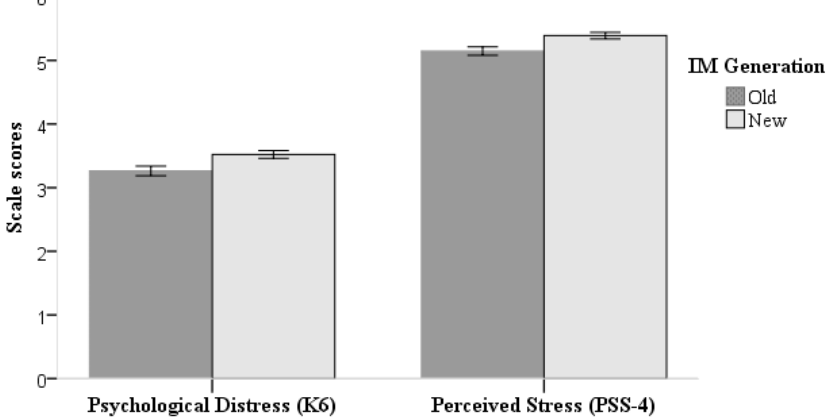
Figure 1. Differences in mental health between new- and old-generation migrants. Abbreviation: IM = internal migrant. Error bars represent 95% confidence intervals. Table 2. The intergenerational disparity in the mental health of internal migrants, 2014.